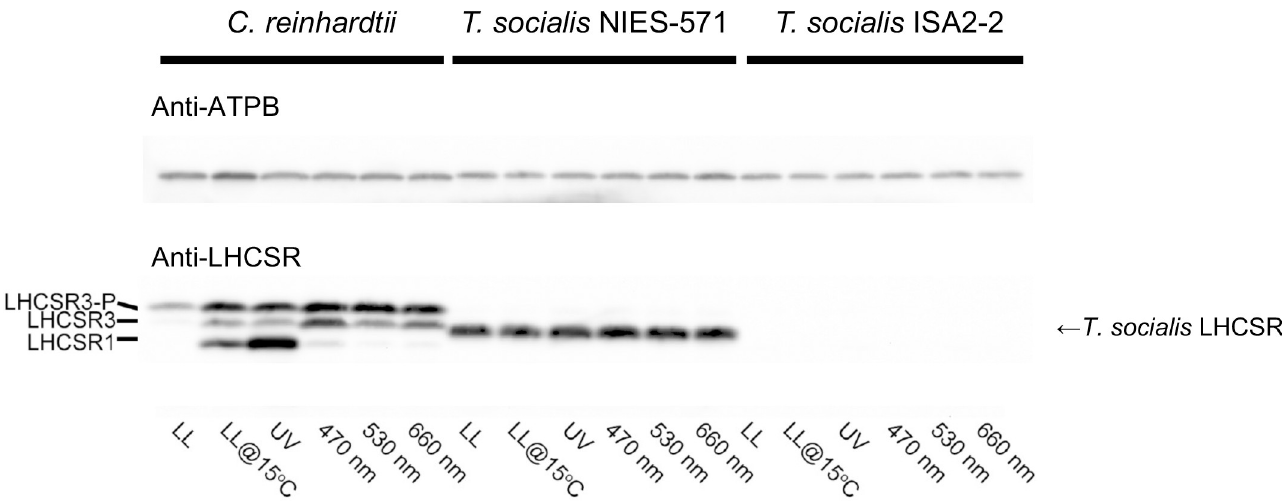
Fig 7. Expression of LHCSR proteins in C . reinhardtii and T . socialis under various light conditions . Western blotting against whole-cell extracts (WCE) of wild- type C . reinhardtii and T . socialis NIES-571 and ISA2-2 strains using the antibody to detect C . reinhardtii LHCSR proteins (lower panel) or anti-ATPB (the beta subunit of ATP synthase) (upper panel) as a loading control. WCE were prepared after the same light/temperature treatment as Fig 6. LHCSR3-P: phosphorylated LHCSR3.